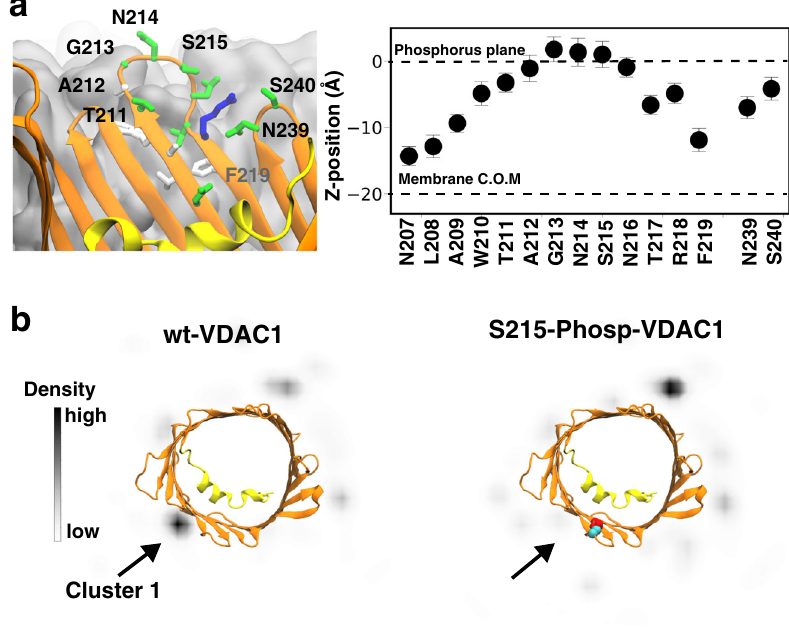
Fig. 6 Phosphorylation of S215 in VDAC1 disrupts HKII/VDAC1 binding. a Cytosolic accessibility of S215. VDAC1 barrel viewed from the membrane plane, highlighting the position of S215 at a location accessible to bulk solvent (left panel). The membrane is colored in gray. (Right panel) Mean and standard deviation of the relative positions along the membrane normal ( z -position) of the COM the side-chain of highlighted VDAC1 residues ( light ), derived from a 200-ns MD simulation of membrane-embedded VDAC1. b Top-down (cytosolic) view of the xy projection of densities of the COM of the H- anchor bound to VDAC1 during the BD simulations. The densities are obtained using all 100 independent replicates of the BD simulations for wt-VDAC1 (left) and S215-phosphorylated (S215-Phosp-VDAC1,